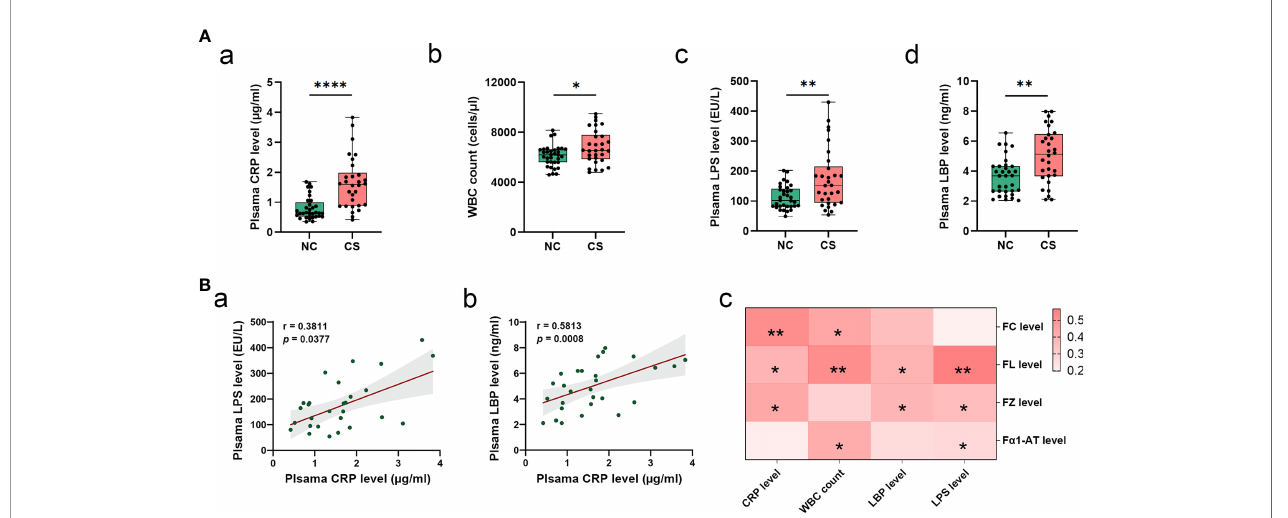
FIGURE 2 | Systemic in fl ammatory in CS patients. (A) Comparison of systemic in fl ammatory biomarker levels (CRP, WBC count, LPS, and LBP) in CS patients and the controls. Results are expressed as median and quartile. (B) Spearman ’ s correlation analysis between plasma LPS and LBP levels and plasma CRP levels (a, b) . Heatmap of Spearman ’ s correlation analysis between systemic in fl ammatory indices (LPS, LBP, CRP, and WBC count) and fecal in fl ammatory biomarkers (FC, FL, and FZ, and F a 1-AT) (c) . p < 0.05 indicates statistical signi fi cance (* p < 0.05, ** p < 0.01, **** p < 0.0001). CS, cryptogenic stroke; CRP, C- reactive protein; WBC, white blood cells; LPS, lipopolysaccharide; LBP, lipopolysaccharide-binding protein; FC, fecal calprotectin; FL, fecal lactoferrin; FZ, fecal zonulin; F a 1-AT, fecal